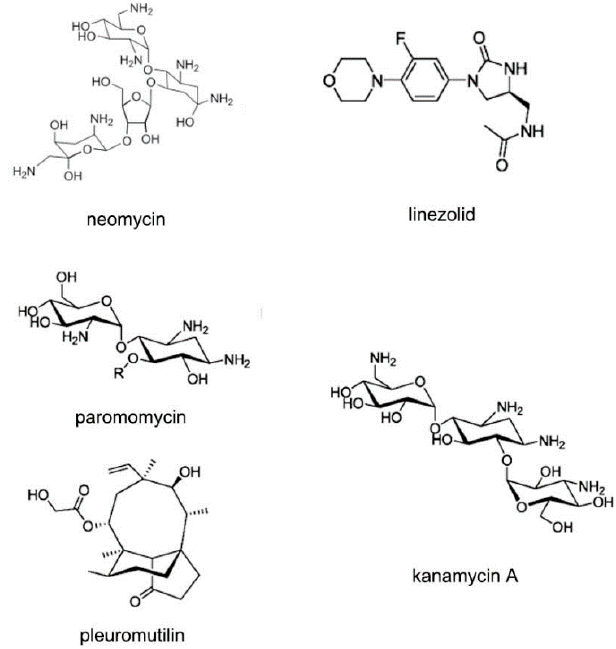
Figure 20. Typical structures of small molecules for 30S or 50S subunit of rRNA.